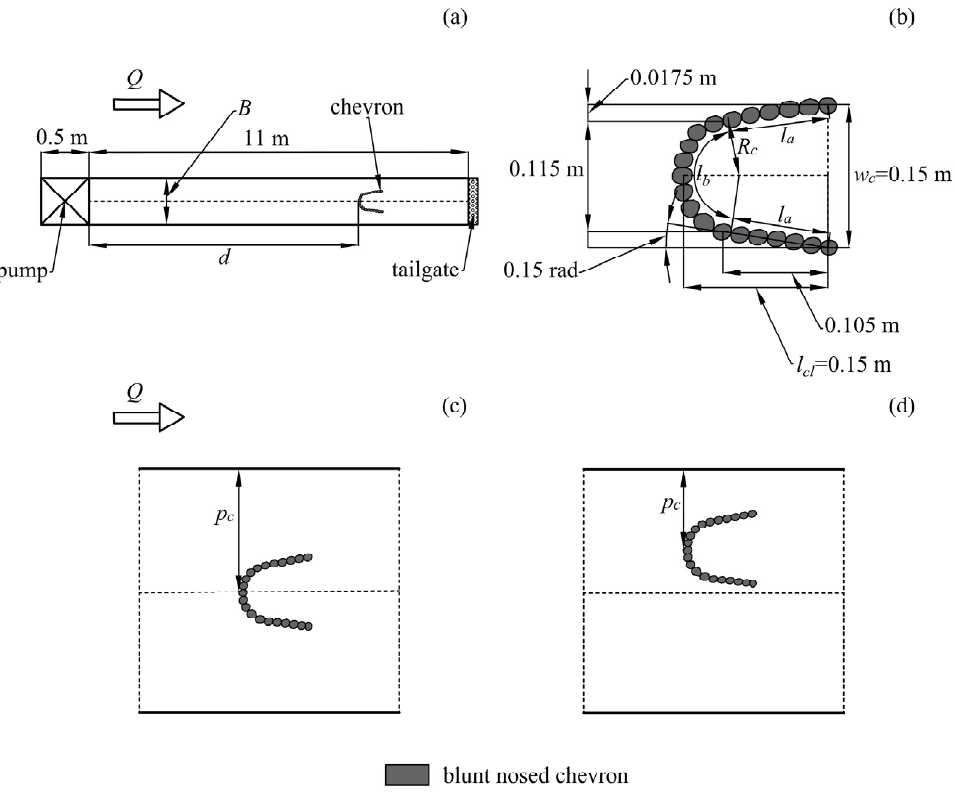
Figure 1. ( a ) Test channel showing the longitudinal chevron position (not in scale), ( b ) geometry of a typical chevron structure used in the study and transversal chevron position at ( c ) p c / B = 0.5 and ( d ) p c / B = 0.33.